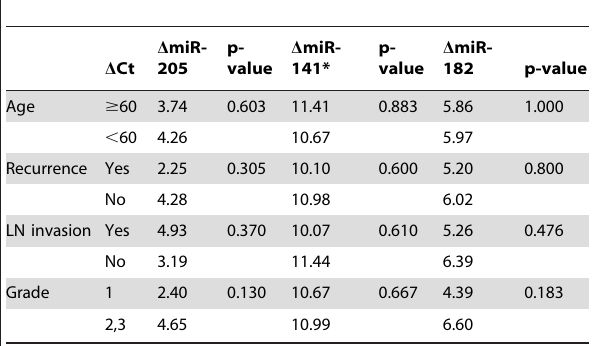
Table 3. Relationship between miRNA expressions and various clinicopathologic prognostic